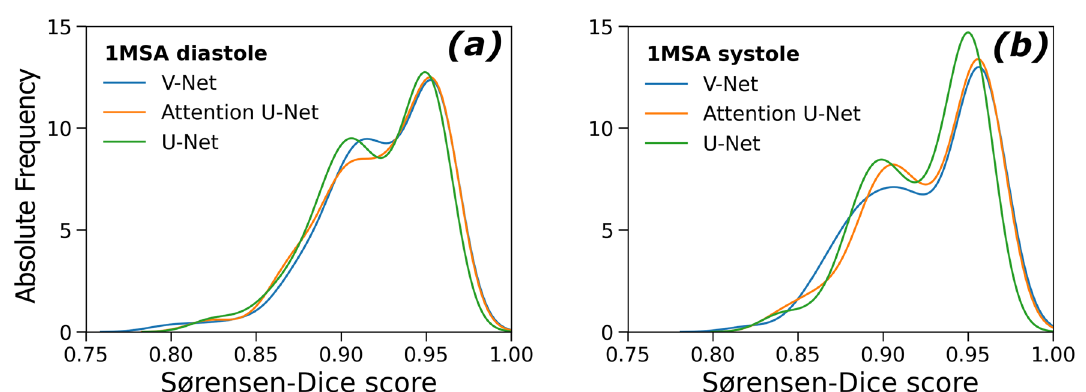
Figure 2. Sørensen-Dice score absolute frequency distribution for 1MSA models for pooled Study 5 and Study 6 where diastole and systole phases were separated manually for the sake of analysing different behaviours. ( a ) Diastole segmentation (V-Net: 0.93 ± 0.032, Attention U-Net: 0.93 ± 0.032, U-Net: 0.93 ± 0.030). ( b ) Systole segmentation (V-Net: 0.93 ± 0.033, Attention U-Net: 0.93 ± 0.031, U-Net: 0.92 ±